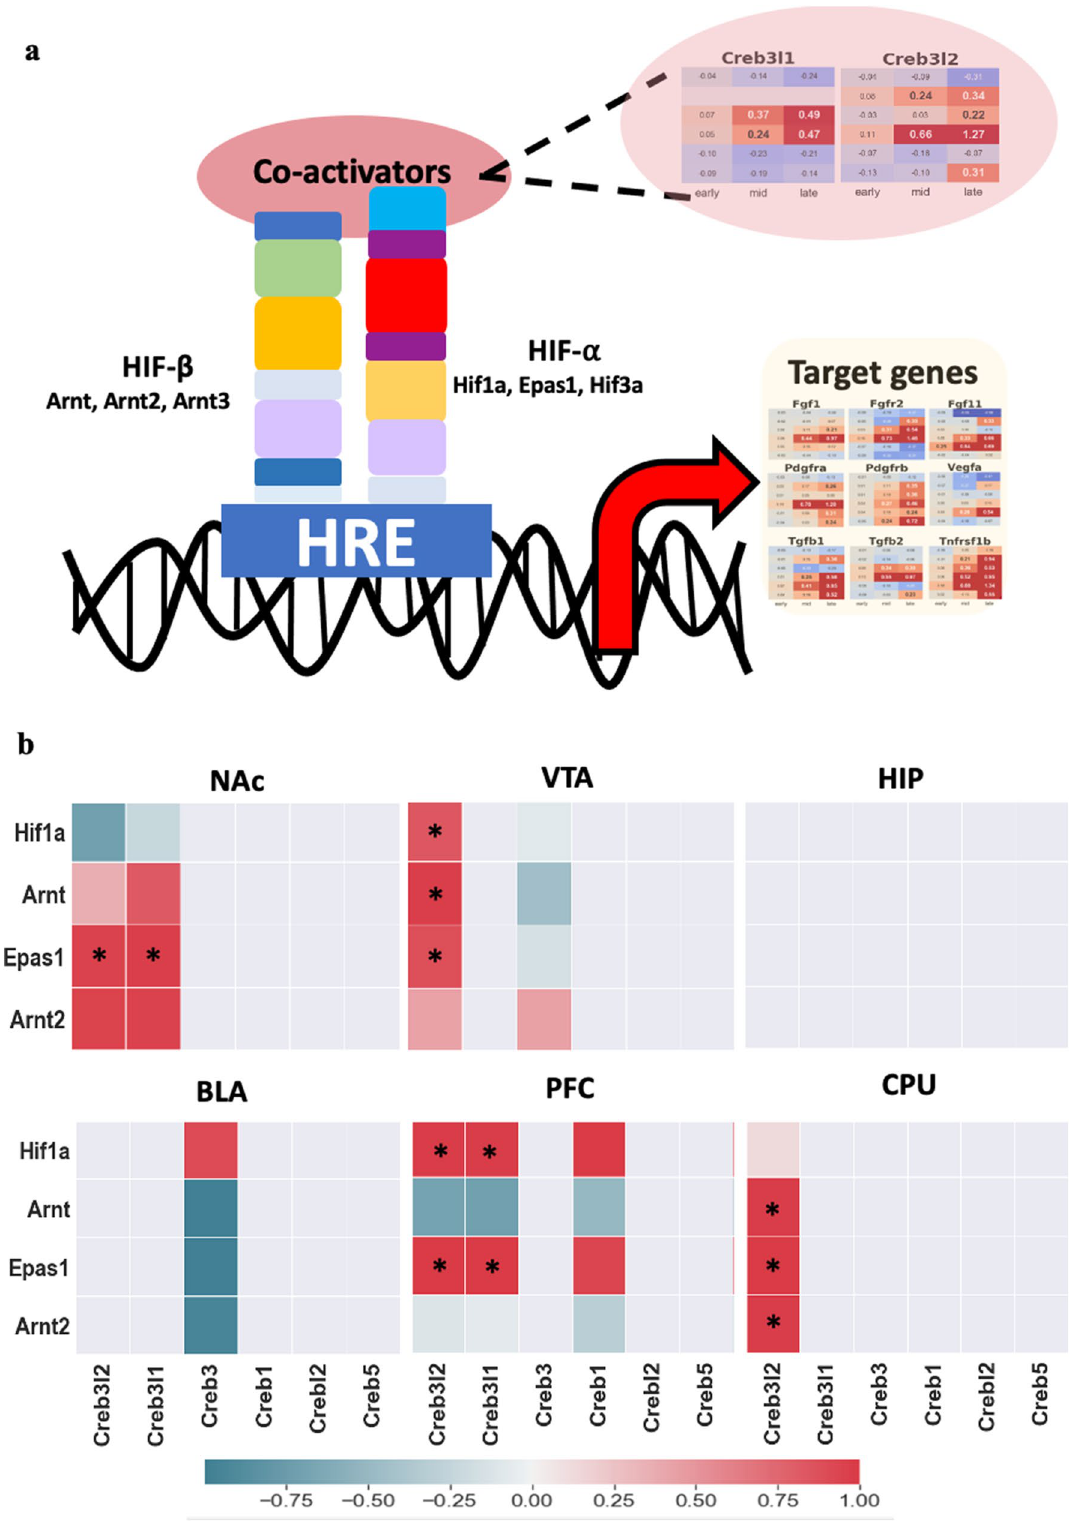
Figure 6. Member of OASIS family as co-activators for HIF family. ( a ) Description of Creb3l1 and Creb3l2 as co-activator with HIF family for mediating angiogenesis. ( b ) Coregulation between HIF and OASIS family. Colored rectangles indicate only upregulation gene. Asterisk *indicates differentially expressed genes (Log2FC > 0.2) on both rows and columns. Reddish color indicates positive correlation between the genes. Teal color indicates negative